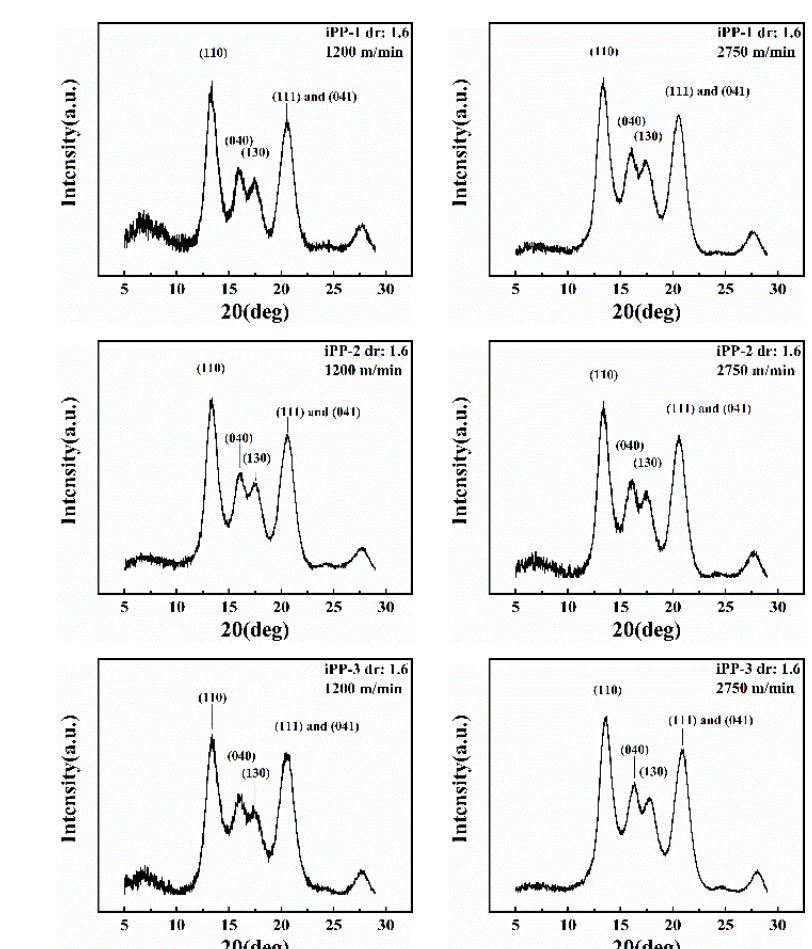
Figure 10. 1D-WAXD curves of drawn iPP fibers (draw ratio: 1.6).